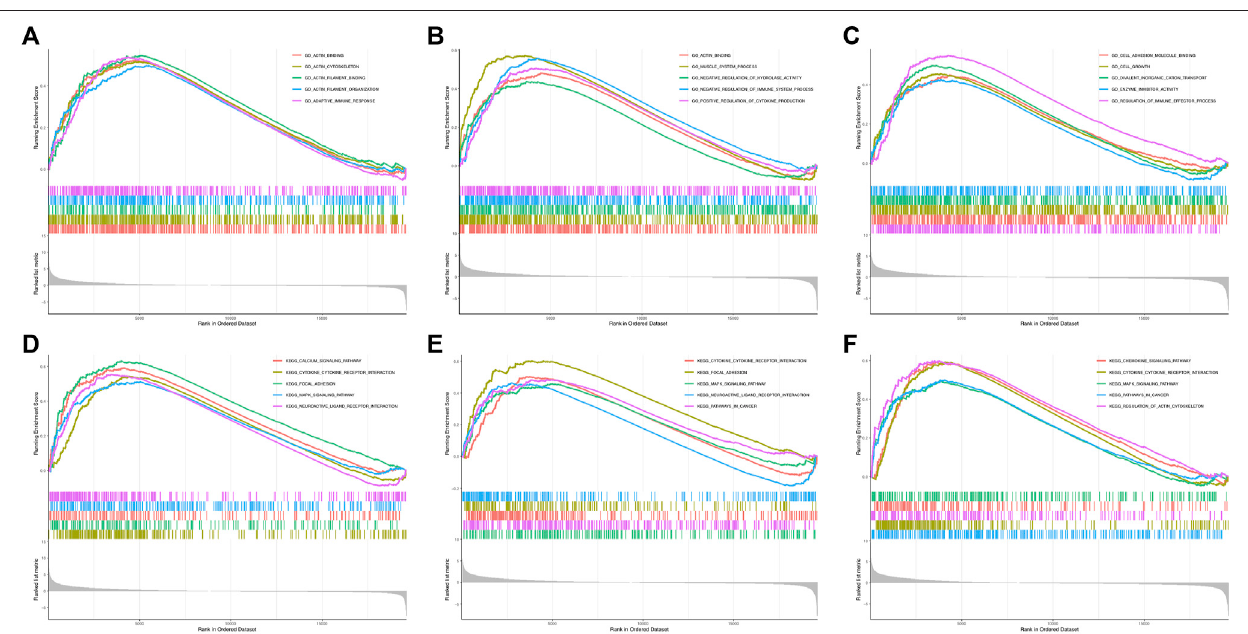
FIGURE 4 | GSEA for DACT3, TNS1, and MSRB3. (A – C) GO enrichment analysis for DACT3, TNS1, and MSRB3. (D – F) KEGG enrichment analysis for DACT3, TNS1, and MSRB3. GSEA: gene set enrichment analysis.